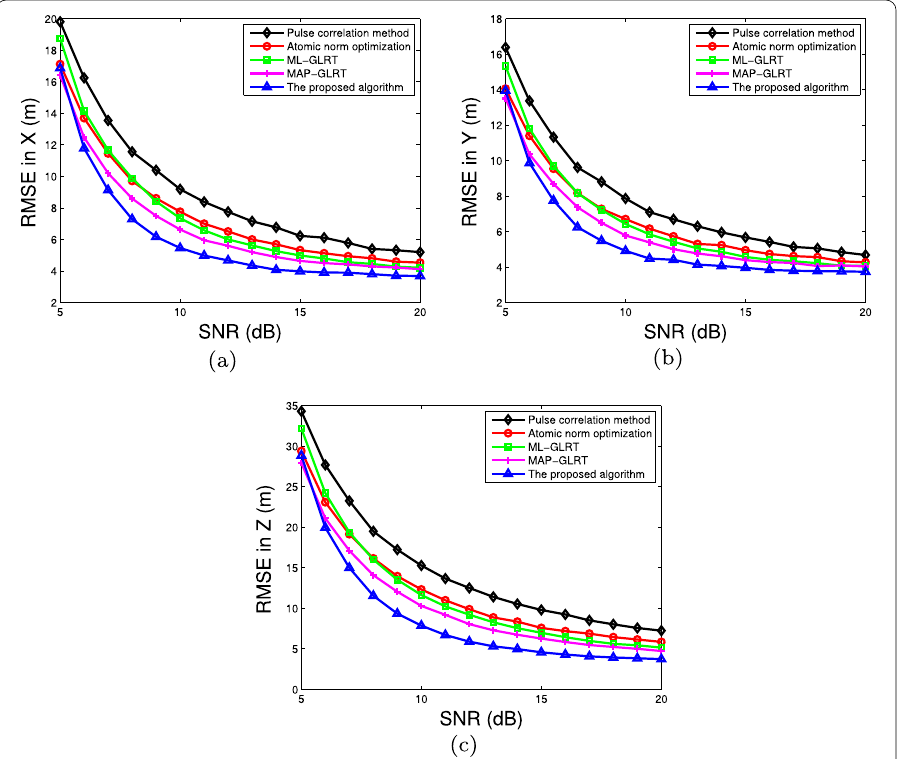
Fig. 16 RMSE of the proposed alignment algorithm compared with the other methods a in X axis b in Y axis c in Z